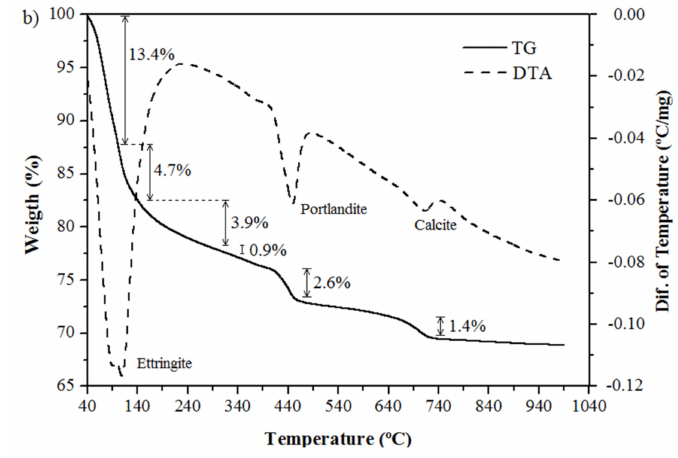
Figure 6. TG and DTA curves of cement pastes: ( a ) REF, and ( b ) SA-10. Heating the REF and SA-10 pastes resulted in physical changes with similar thermal behavior. The first mass loss event was identified in the range between 40 ◦ C and 100 ◦ C, representing a loss of 12.3% and 13.4%, respectively, attributed to the effects of ettringite decomposition, which occurs at around 70–90 ◦ C